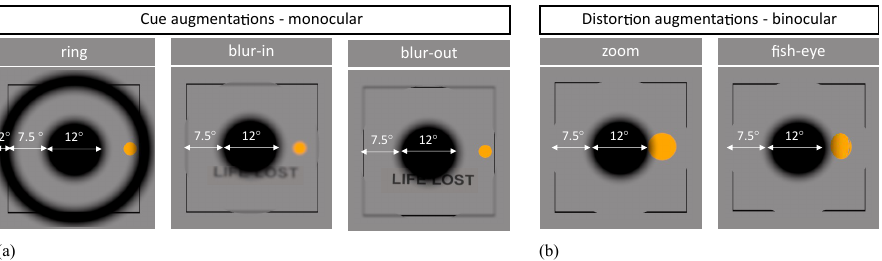
Figure 2. Screenshots and specifications of the monocular ( a ) and binocular augmentations ( b ) as they looked in the VR environment and the different impacts they had on the target. The big black circle is the gaze-contingent scotoma simulation, and the yellow one is the target: the ball. A text is added to show better the bluring effect for the blur-in and blur-out